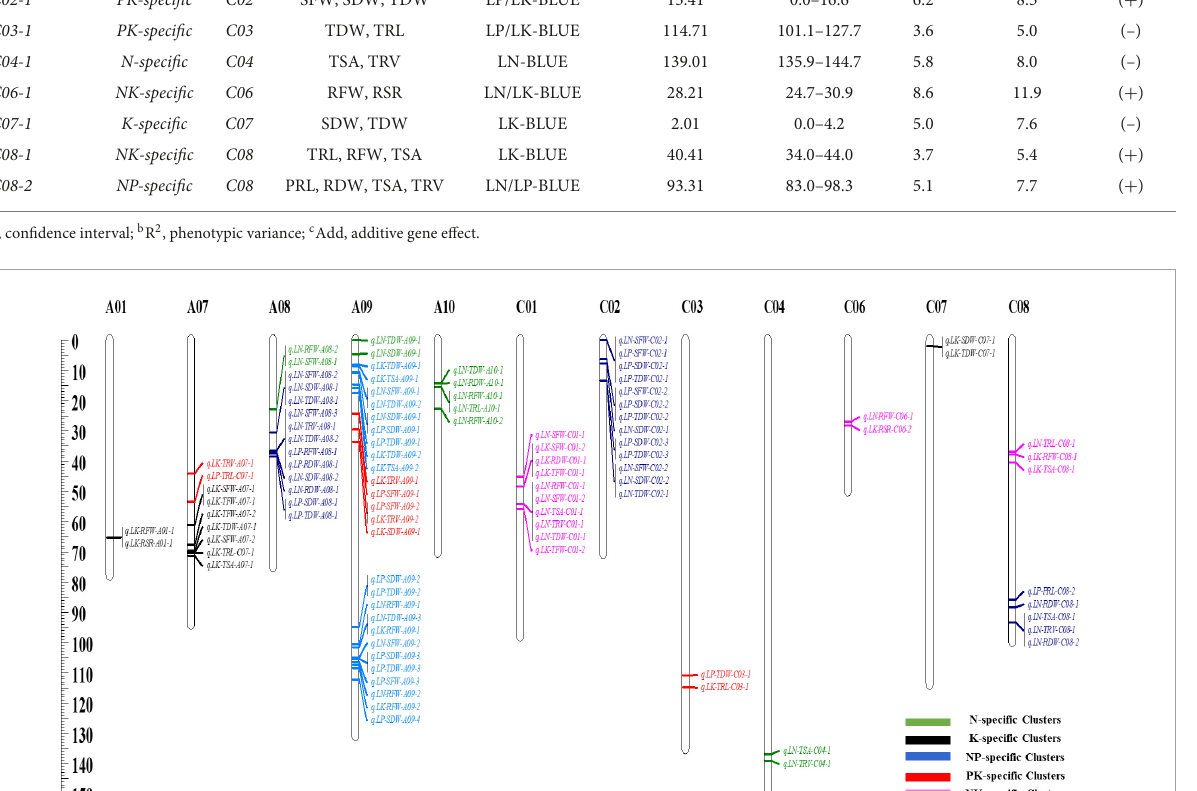
in the root, stem, cotyledon, silique, silique wall, leaf, seed, and bud, implying that they are involved in plant growth and development ( Figure 5A